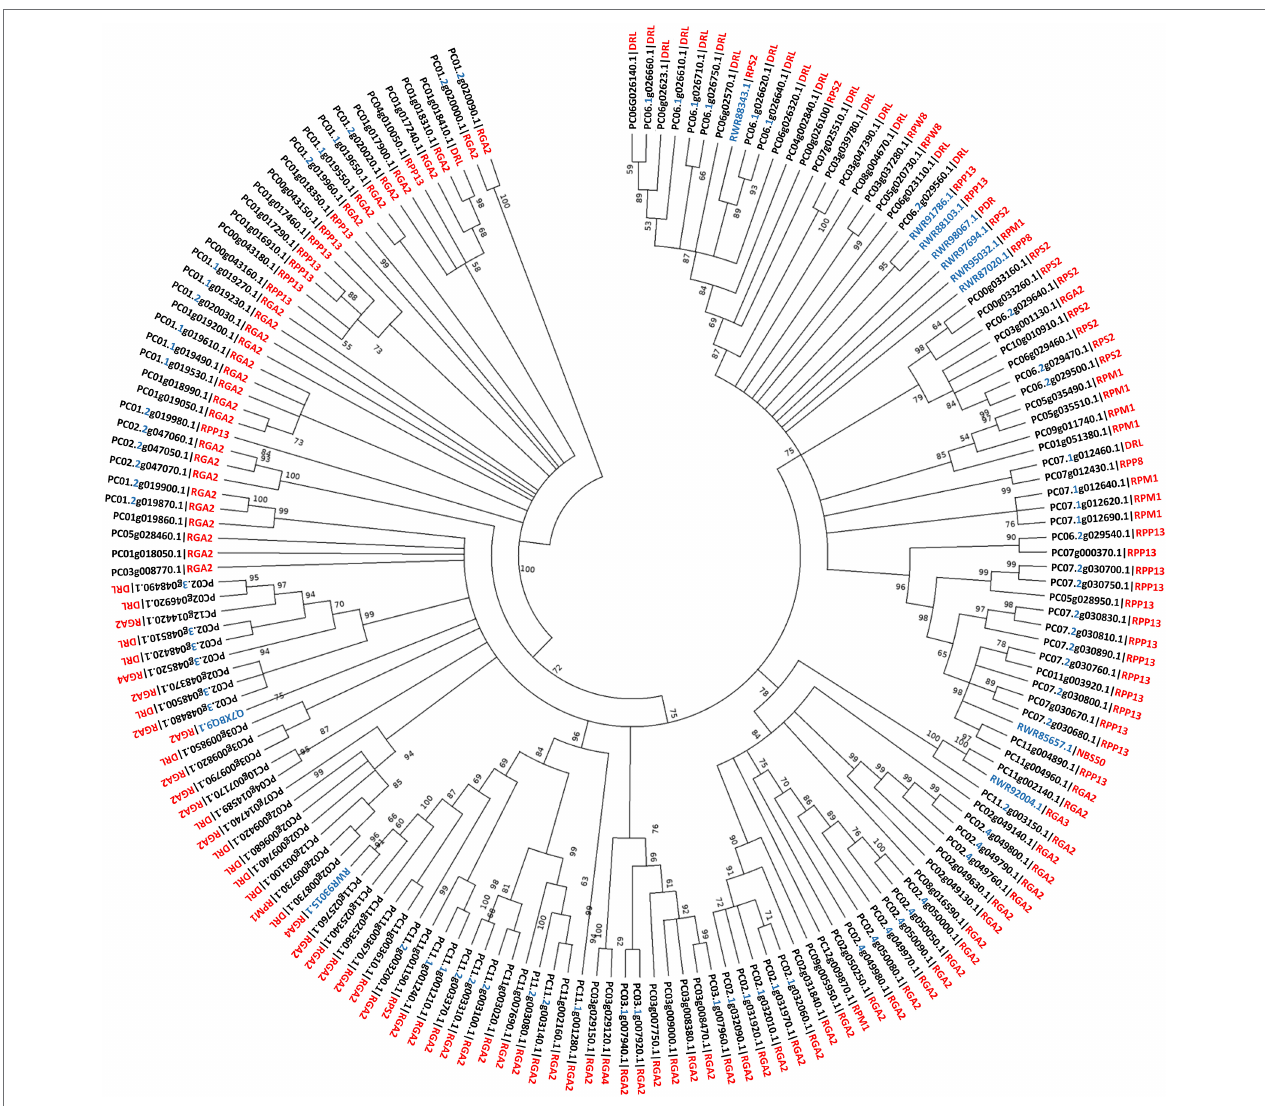
FIGURE 3 | Phylogenetic relationship of 161 Persea americana (West-Indian pure accession) Nucleotide binding domains from putative PaNLR genes. Evolutionary history was inferred using the Maximum likelihood method and JTT matrix-based model following ClustalW alignment. A total of 1,000 bootstrap replicates were performed, with bootstrap values over 50 being shown above branch points. NB-domain protein sequences of Persea americana (PC) with complete NLR sequences from Cinnamomum micranthum f. kanehirae (RWR) and Solanum bulbocastanum (Q) were used during the analysis. Persea americana identification numbers include the gene cluster number, where appropriate (in blue) and protein type (in red). Unidentified PaNLR protein types were termed Disease resistance- like (DRL) proteins. Sequences from other species also include protein type (NBS50, NBS-LRR disease resistance protein NBS50; PDR, disease resistance-like protein isoform